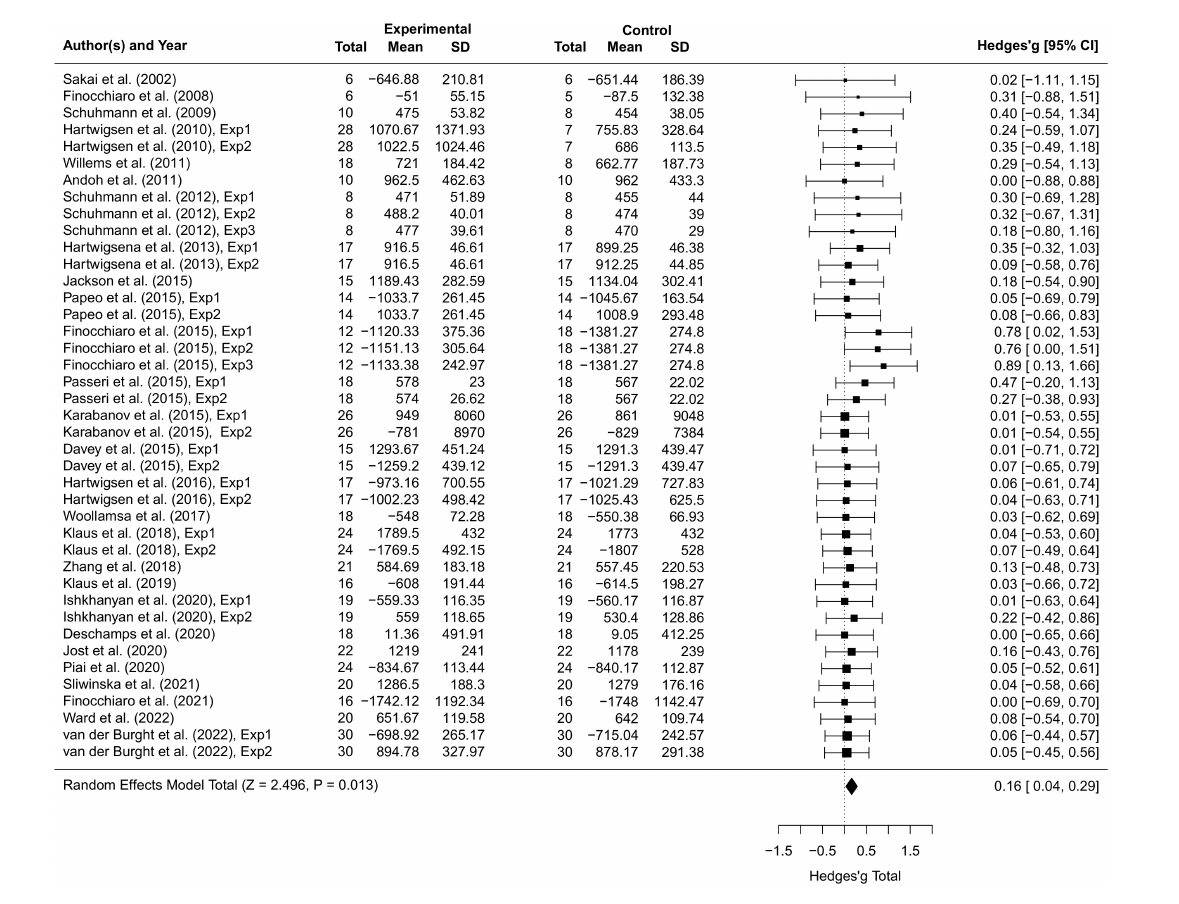
FIGURE3 Forest plot of reaction times (RTs) of overall effect analysis. The discrepancy in sample size between the experimental group and the control group in some studies is due to the between-subject experimental